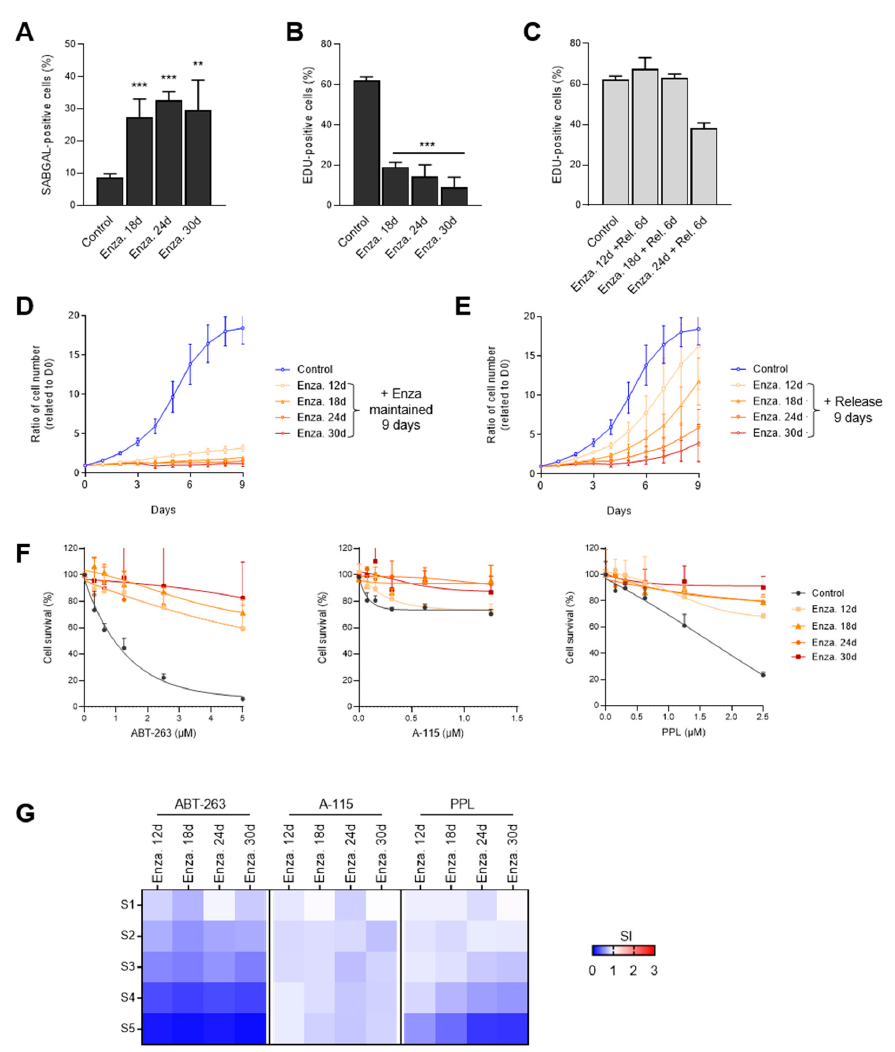
Figure 6. Enza-TIS is reversible. ( A ) SA- β -gal assay and ( B ) quantification of EdU-positive cells were performed in LNCaP cells following 18, 24 or 30 days of enzalutamide (Enza) treatment. ( C ) EdU staining was performed in LNCaP for which 10 µ M Enza was released during the last 6 days of long-term Enza treatment. Cells were pulsed 24 h before the staining. ( A – C ) The mean ± SD of three independent experiments is shown ( D – E ) LNCaP cells expressing H2B-GFP were exposed to 10 µ M Enza for 12, 18, 24 or 30 days and cell proliferation curves were determined for 9 days while Enza was ( D ) maintained or ( E ) released. Data are the mean ± SD of triplicate and are representatives of three independent experiments. ( F ) LNCaP expressing H2B-GFP were exposed to 10 µ M Enza for 12, 18, 24 or 30 days, and then cell survival curves were determined during a 6-day exposure to Enza, alone or in combination with increasing concentrations of ABT-263 (left), A-1155463 (A-115, middle) or PPL (right). Data are the mean ± SD of triplicate and are representatives of three independent experiments. ( G ) Heat maps of senolytic indexes (SI) for LNCaP treated with the indicated combination treatments. S0 to S5 correspond to increasing senolytic concentrations (see Figure S3A). The mean ± SD of three independent experiments is shown. Data were analyzed using the two-tailed Student’s t -test. ** p < 0.01, and *** p <